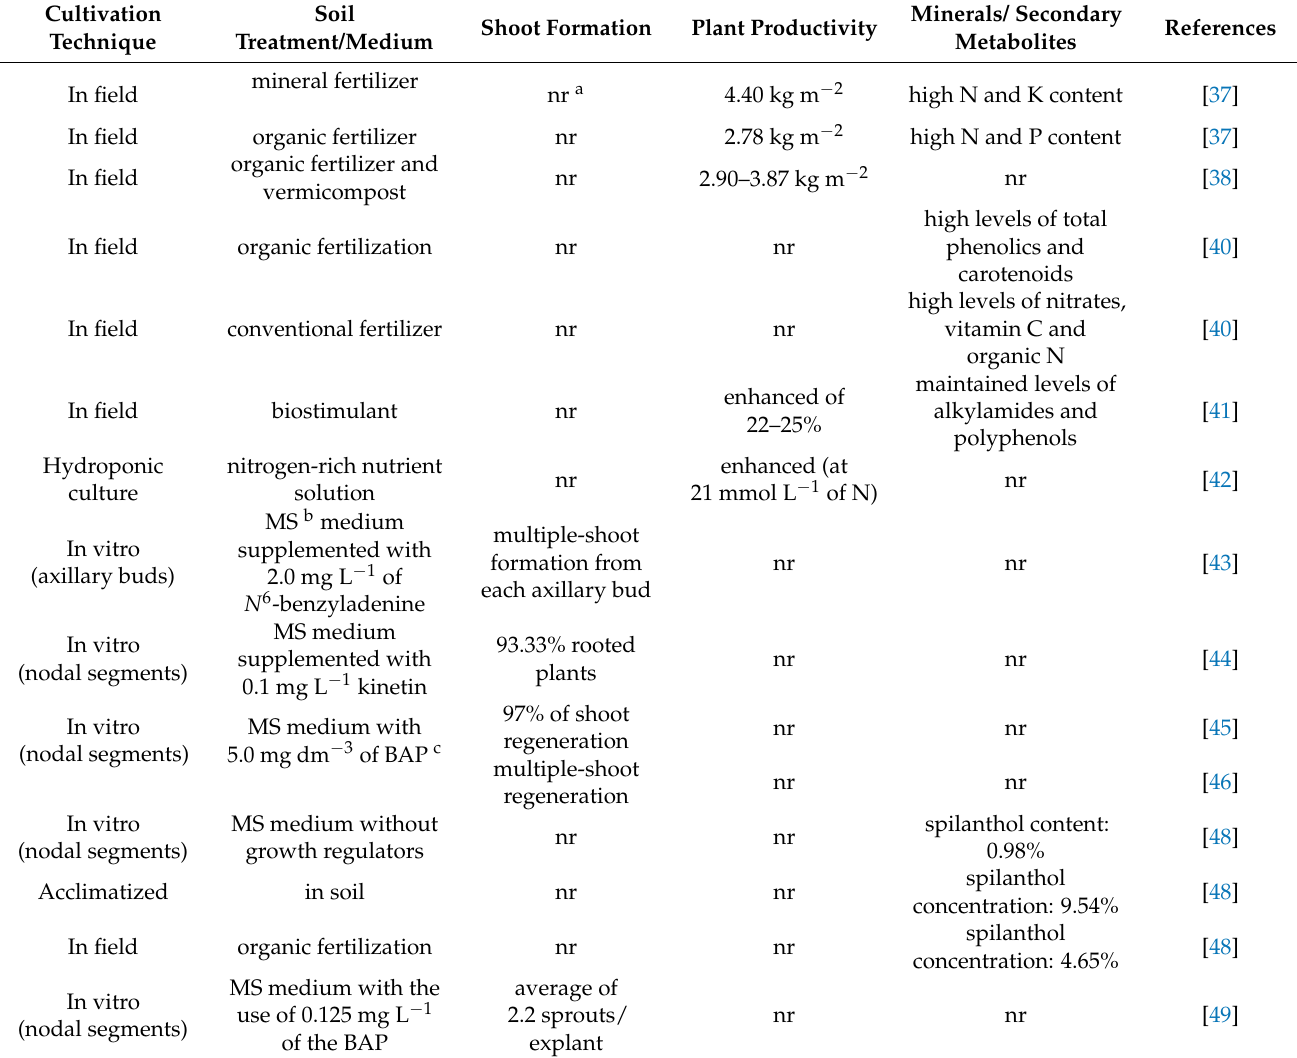
Table 1. Studies on the cultivation techniques of Acmella oleracea